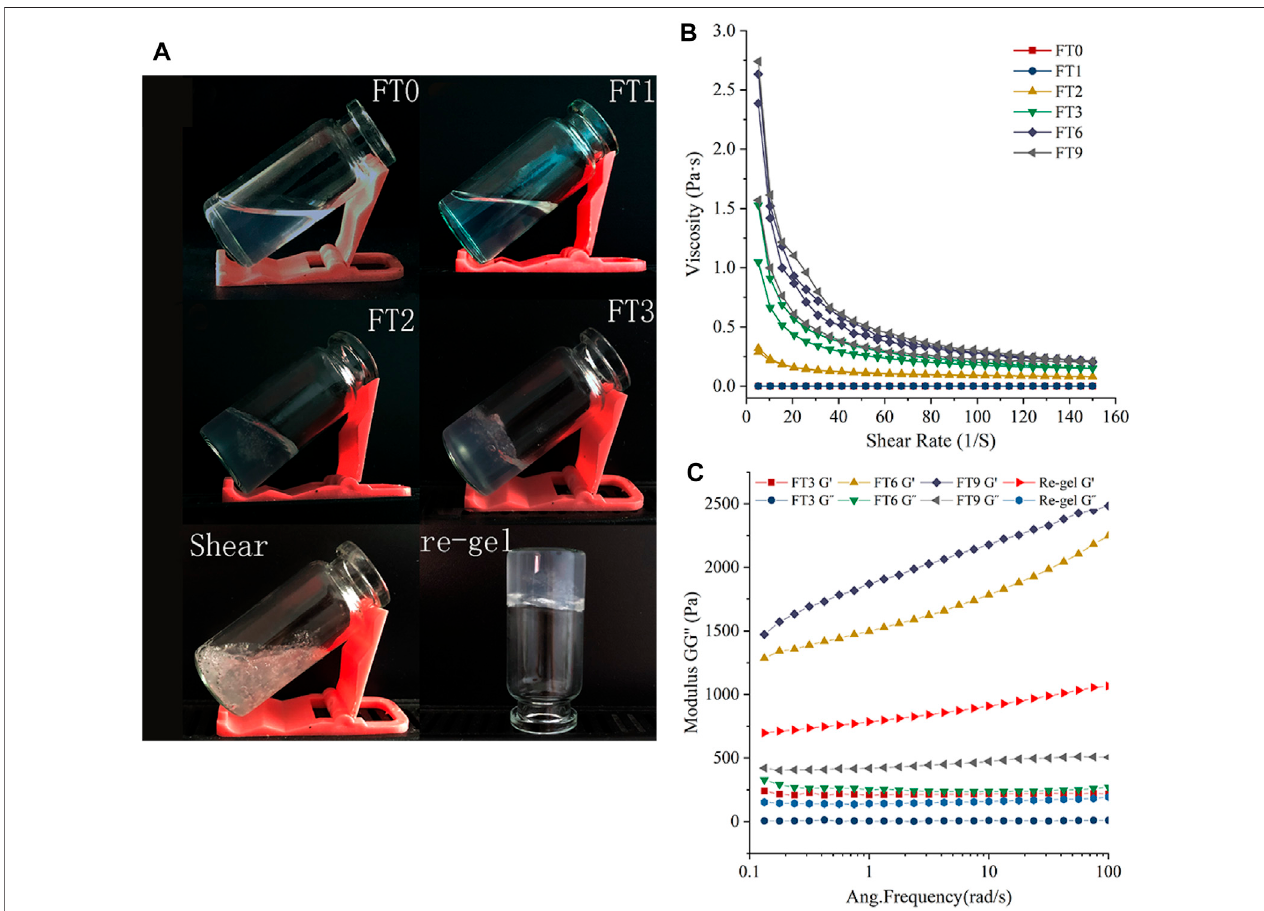
FIGURE 1 | (A) Gelation and Reversible transformation of RHK, (B) viscosity and, (C) oscillatory amplitude sweep measurement of RHK samples at varied FT cycles.